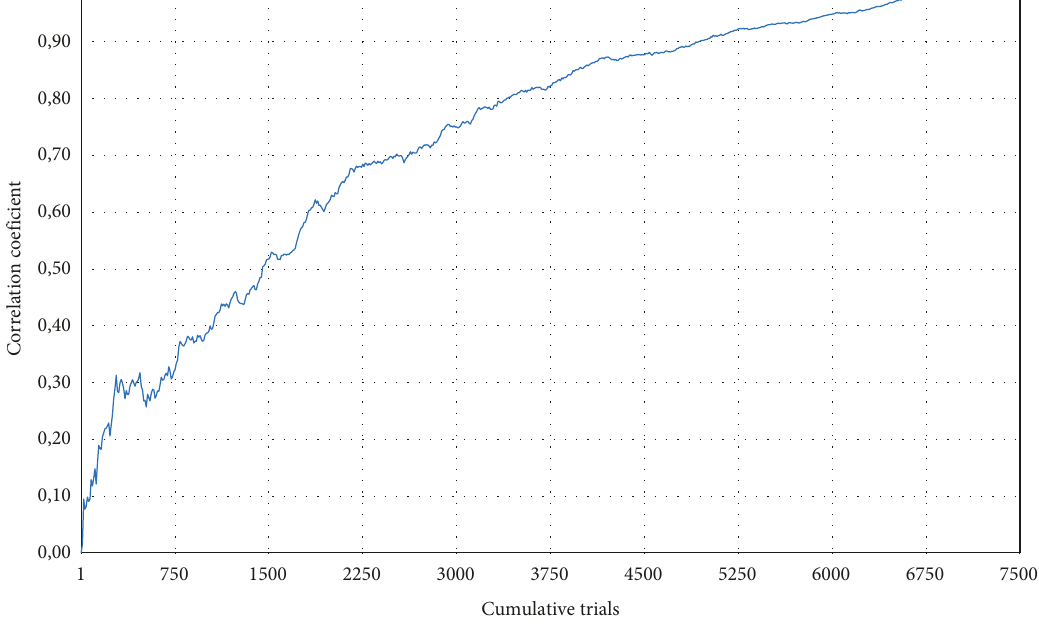
Figure 7: Correlation between cumulative CI and final